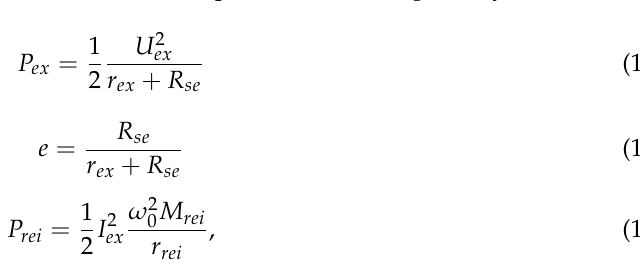
Figure 1. Equivalent circuit of multi-receptor charging system . ( a ) Inductance equivalent circuit; ( b ) Impedance equivalent circuit.